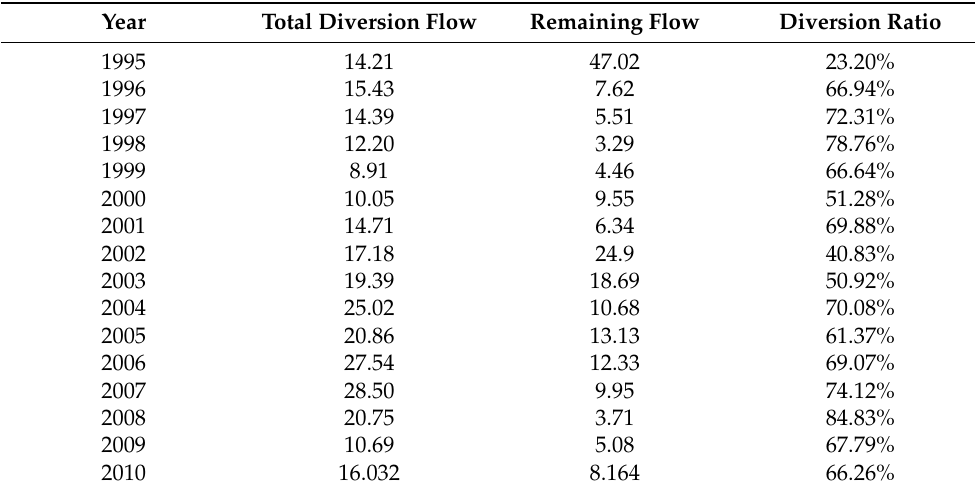
Table 3. Total annual diversions of the